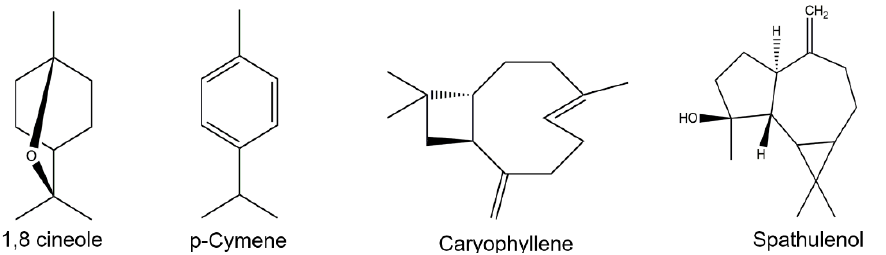
Figure 2. Chemical structures of the major compounds identified in C. conduplicatus essential oil via GC-MS analysis.